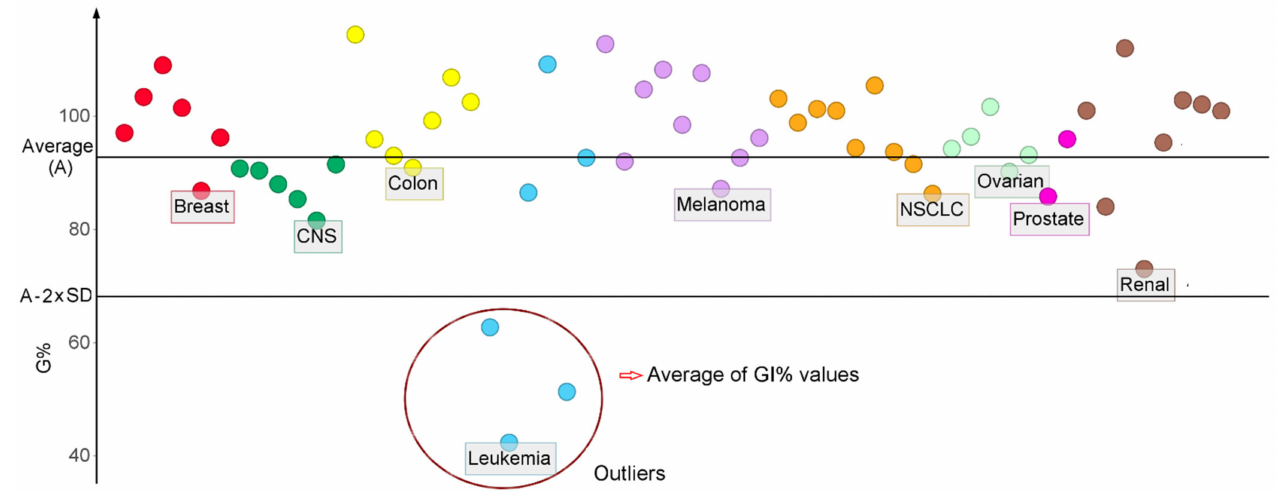
Figure 1. The GI% values for the compound NSC760 on the NCI-60 cells. CNS stands for central nervous system, while NSCLS stands for non-small cell lung cancer. The encircled points represent the GI% values two standard deviations (SD) below the mean (A). The average of the outliers data were used to calculate the SP